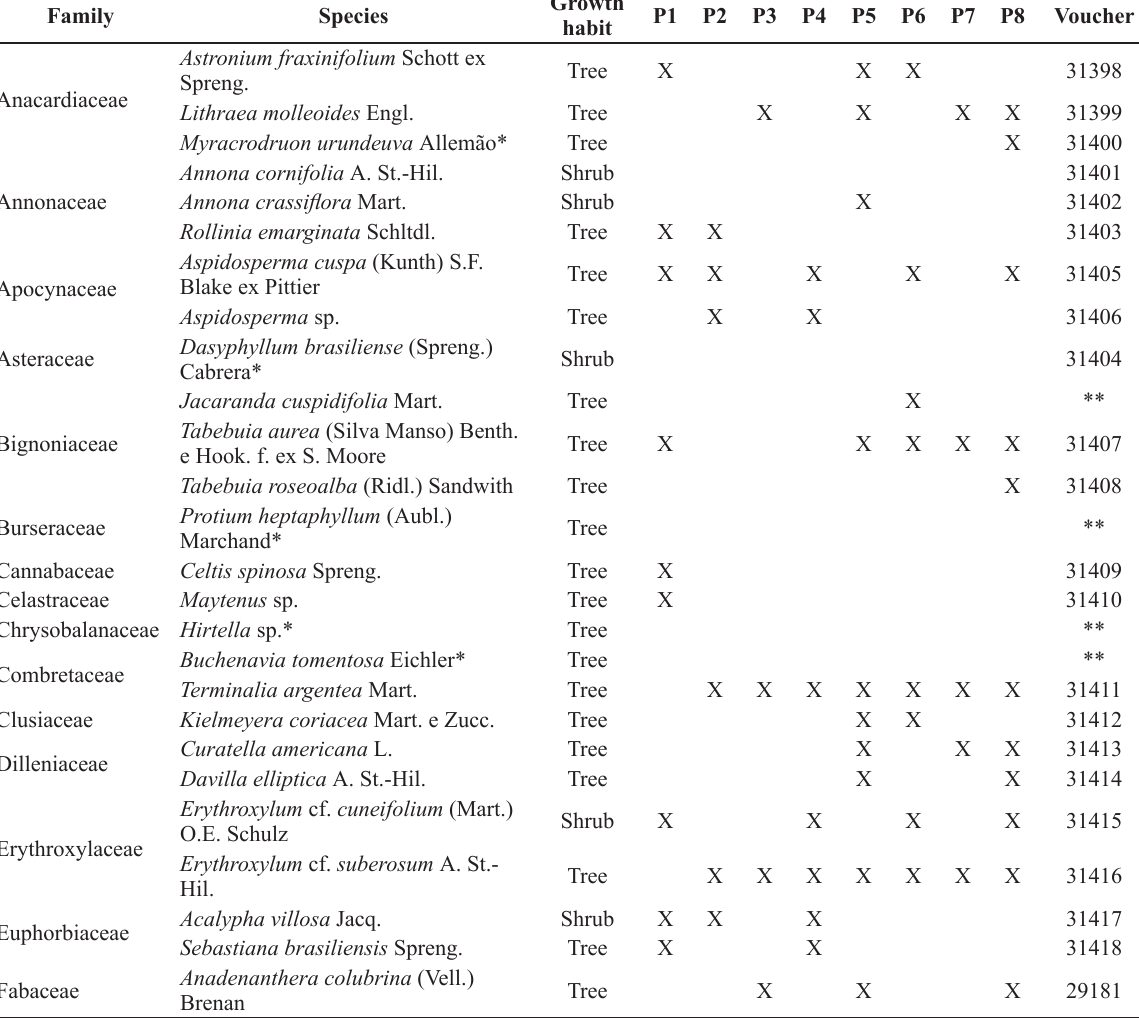
List of families and species present in the plots and respective growth habits on an escarpment slope of the Serra de Maracaju, Mato Grosso do Sul, Brazil. (* species obtained in the plots, ** vegetative material; plots: P1, P2, P3, P4, P5, P6, P7 and P8; Voucher – herbarium